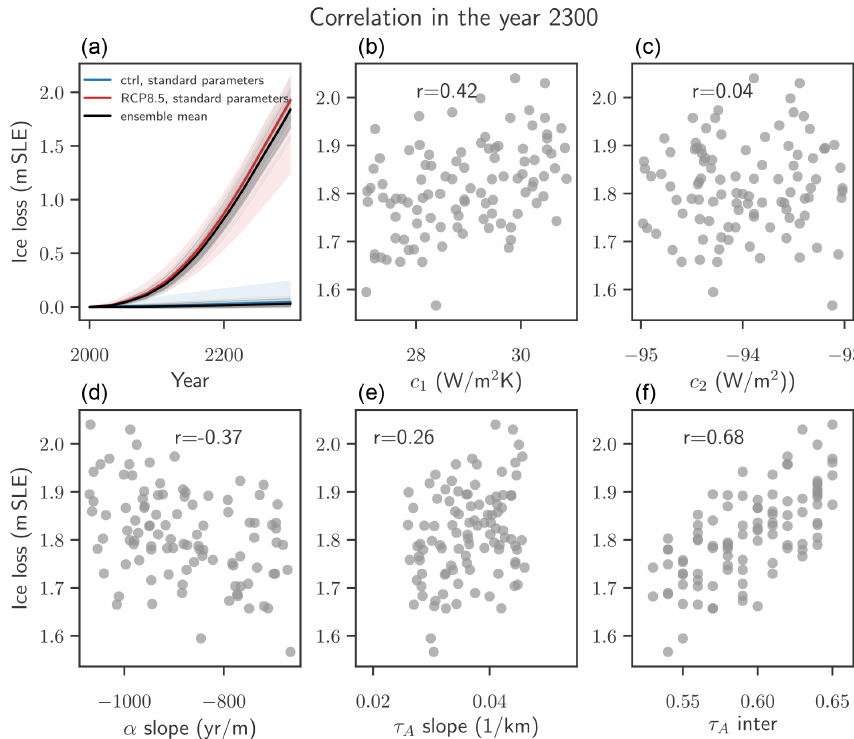
Figure E1. Impact of the parameter variability. (a) Time series of PISM-dEBM-simple simulations of the Greenland Ice Sheet with RCP8.5 warming and control simulations. The thick red and blue line are simulations with standard parameters, and the shading shows the upper and the lower bounds of the melt–albedo feedback, as shown in Fig. 5 and discussed in Sect. 4. The thin black lines are the ensemble simulations, with parameters drawn in randomly and shown in Table E1. Thick black lines show the ensemble average. Ice loss is given in metres of sea level equivalent. A value of 1ms.l.e. corresponds to approx. 361800Gt of ice. (b–f) Ice loss until the year 2300 in ms.l.e. vs. each of the varied parameters. Note that here the ice loss is corrected by the respective control simulation, which uses the same set of parameters but has no temperature forcing. The Spearman correlation coefficient is given in each of the panels.